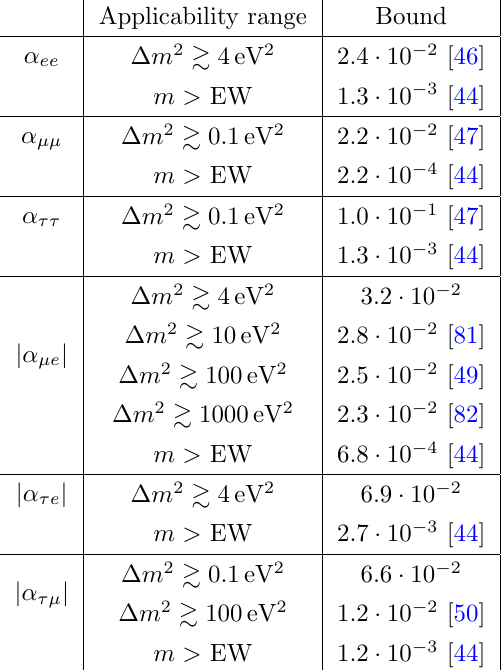
Table 2 . Summary of the current experimental constraints in the averaged-out regime, applicable to sterile neutrinos above a certain mass range. The bounds on the o(cid:11)-diagonal elements which do not have a reference have been obtained indirectly from the bounds on the diagonal elements at p that scale, using (cid:11) (cid:11)(cid:12) (cid:20) 2 (cid:11) (cid:11)(cid:11) (cid:11) (cid:12)(cid:12) (see eq. (3.5)).